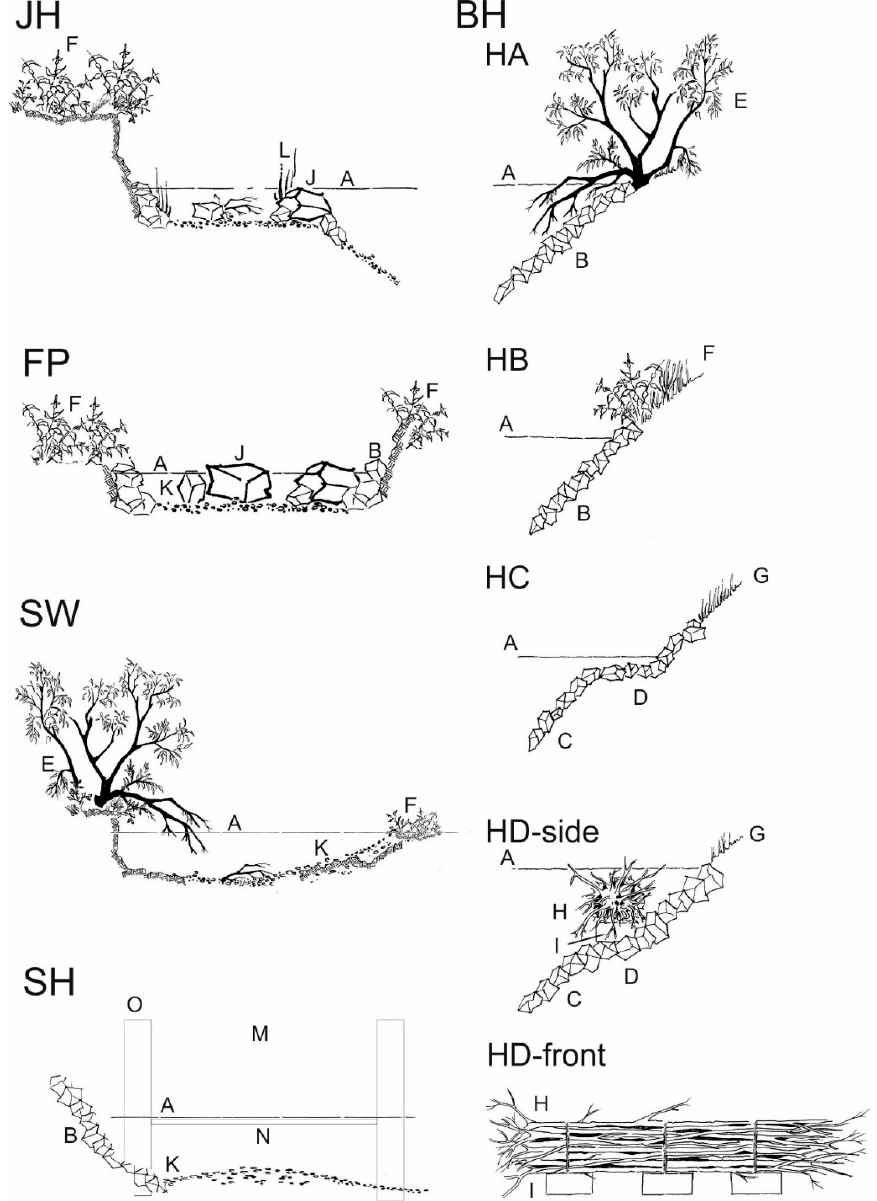
Figure 3. Magnification of the five different assessed habitat types of the river Günz. All drawings are lateral cuts and are without scale. JH = structured shallow water zone [18], BH = bank habitats (with the four different designs HA, HB, HC, and HD as described above and in Pander and Geist [3,4]), SW = former river course below the spillway, SH = fast flowing instream habitat with gravel, FP = nature like fish pass. HA = boulder rip-rap with natural grown riparian wood, HB = boulder rip-rap with shrubs, HC = benched boulder rip-rap with grass vegetation, HD-side = side-view of the deadwood fascine with its positioning on the rip-rap, HD-front = front-view indicating the structure of deadwood fascine and the anchoring. Habitat features A-I are also describes in Pander and Geist [3,4] with “A = water surface level, B = boulder rip-rap with limestone 40 cm–80 cm size, C = boulder rip-rap with limestone 20 cm–40 cm size, D = benched bank reinforcement, E = natural grown riparian wood, F = natural grown shrubs, G = sowed grass mixture, H = artificial made dead wood fascine, I = concrete block to anchor the fascine.” J = limestone boulder 80 cm–100 cm size, K = introduced gravel (SW = grain size 8 mm–32 mm, JH and SH = grain size <0.85 mm–56 mm with less than 12% grain size <0.85 mm, FP = grain size 32 mm–63 mm), L = macrophytes, N = turbine outlet, M = power house of the power plant, O = guiding walls at the turbine outlet.